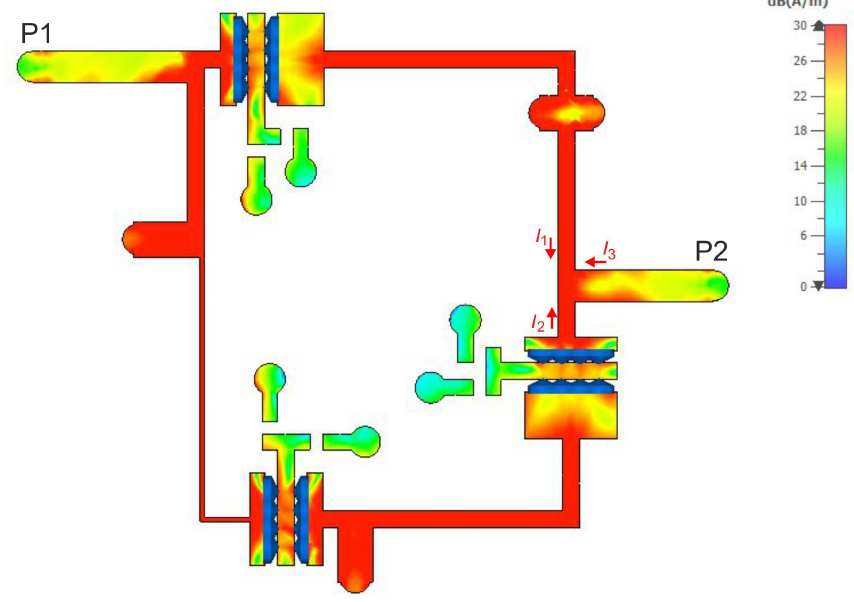
Figure 17. Current density distribution at the center frequency (585 MHz) of the filter.